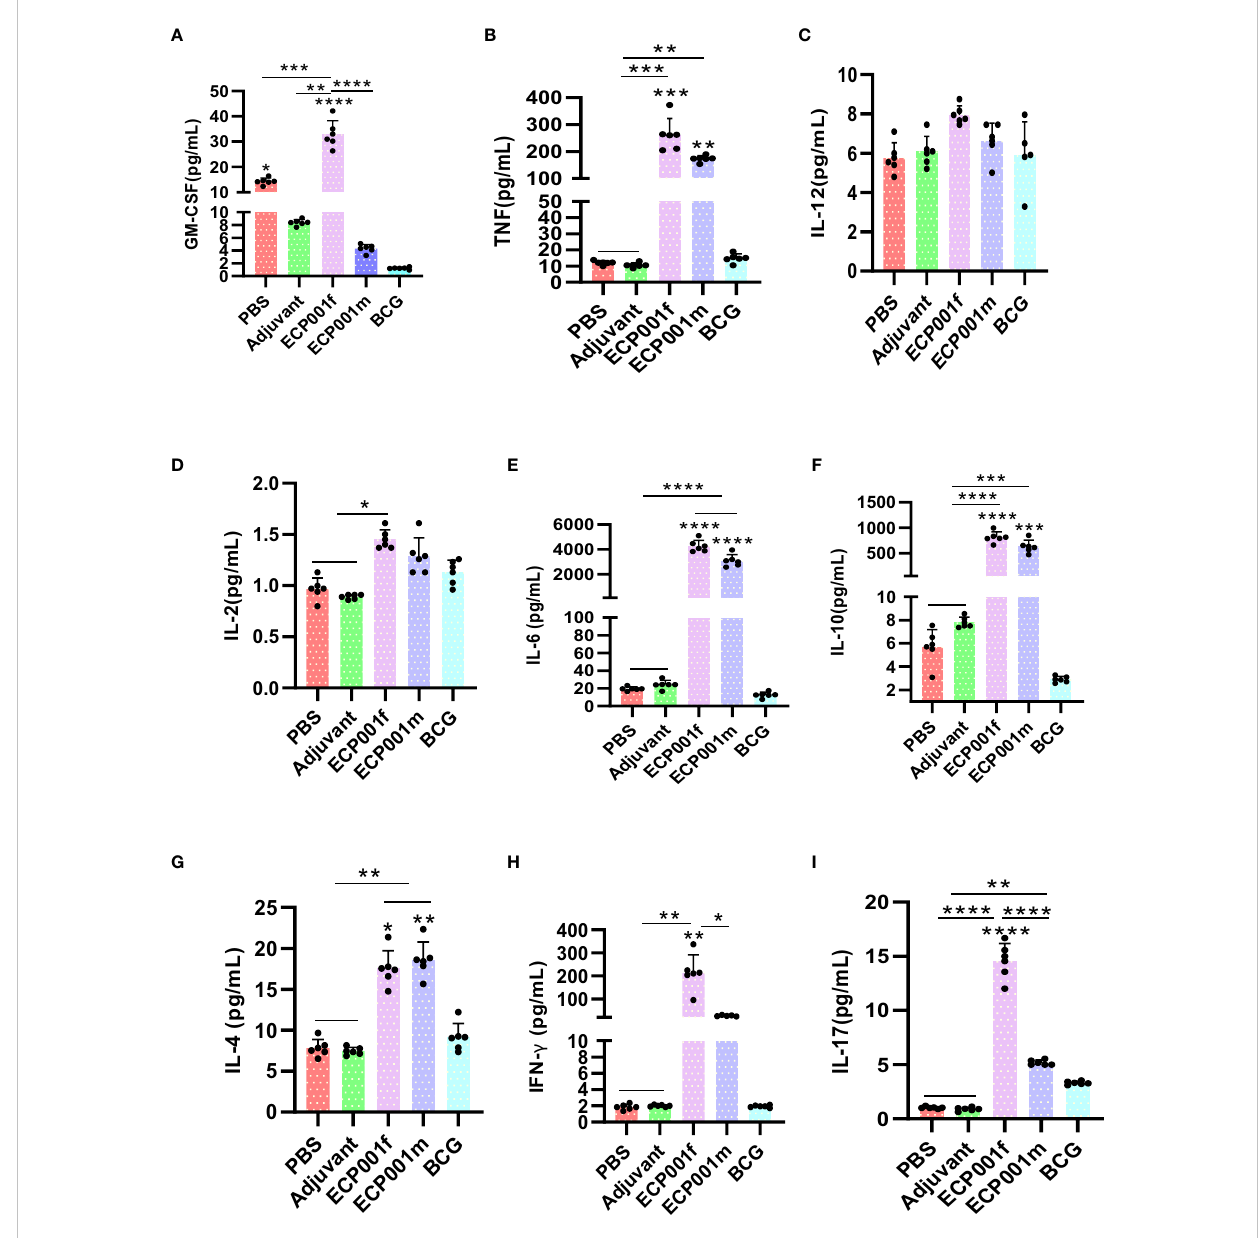
FIGURE 6 Speci fi c cytokines produced by mouse splenocytes after in vitro antigen stimulation after immunization with ECP001f and ECP001m compared to PBS, Adjuvant and BCG group. (A) GM-CSF concentration produced by mouse splenocytes following in vitro antigen stimulation; (B) TNF- a ; (C) IL- 12; (D) IL-2; (E) IL-6; (F) IL-10; (G) IL-4; (H) IFN- g ; (I) IL-17. Statistical differences among the four groups of PBS, adjuvant, ECP001f and ECP001m were indicated by asterisks above the lines between the groups, while statistical differences between the four groups and BCG group were directly indicated by asterisks above their respective columns (* P <0.05, ** P <0.01, *** P <0.001, **** P <0.0001; ns means no statistically signi fi